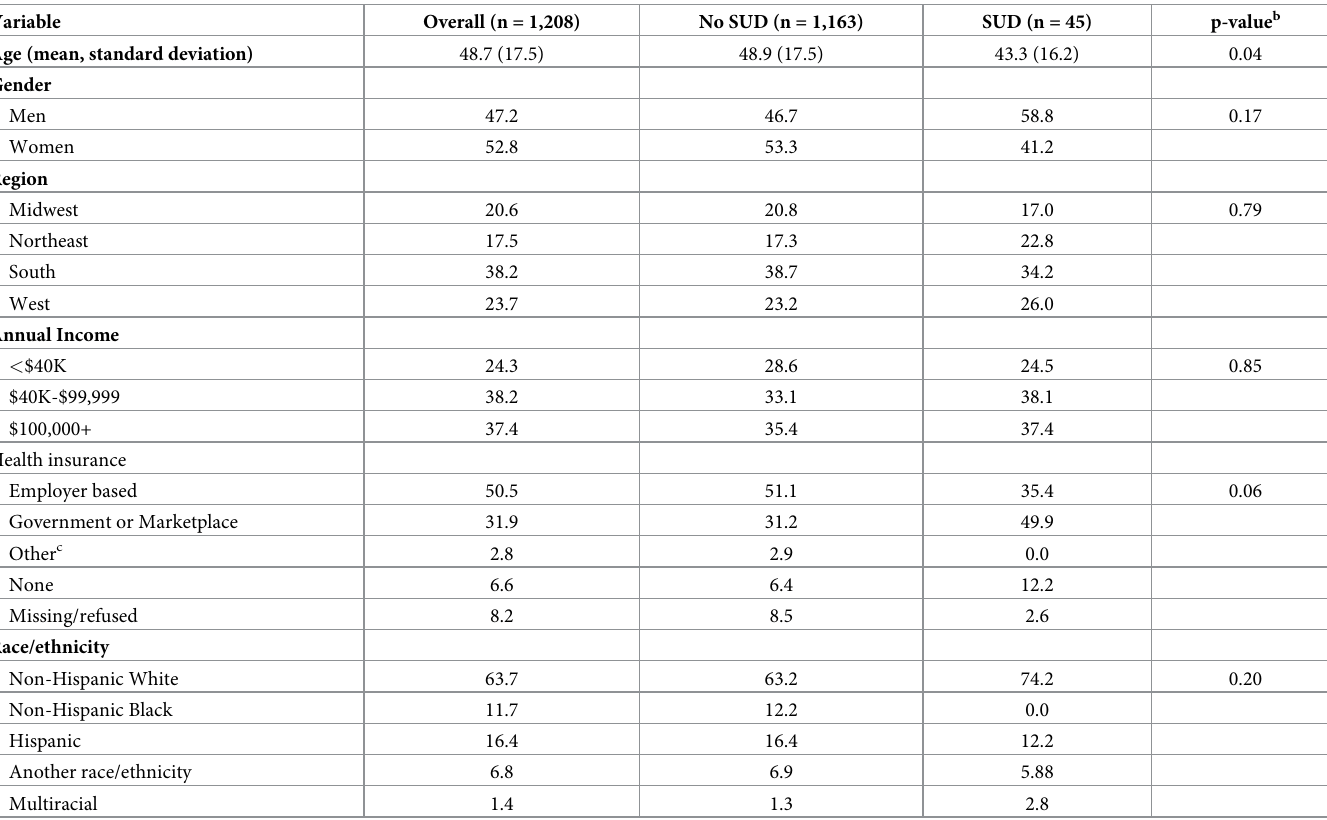
Table 1. Survey participant characteristics by SUD status (% a , unless otherwise specified), U.S., May 29-June 10 2020, (n =